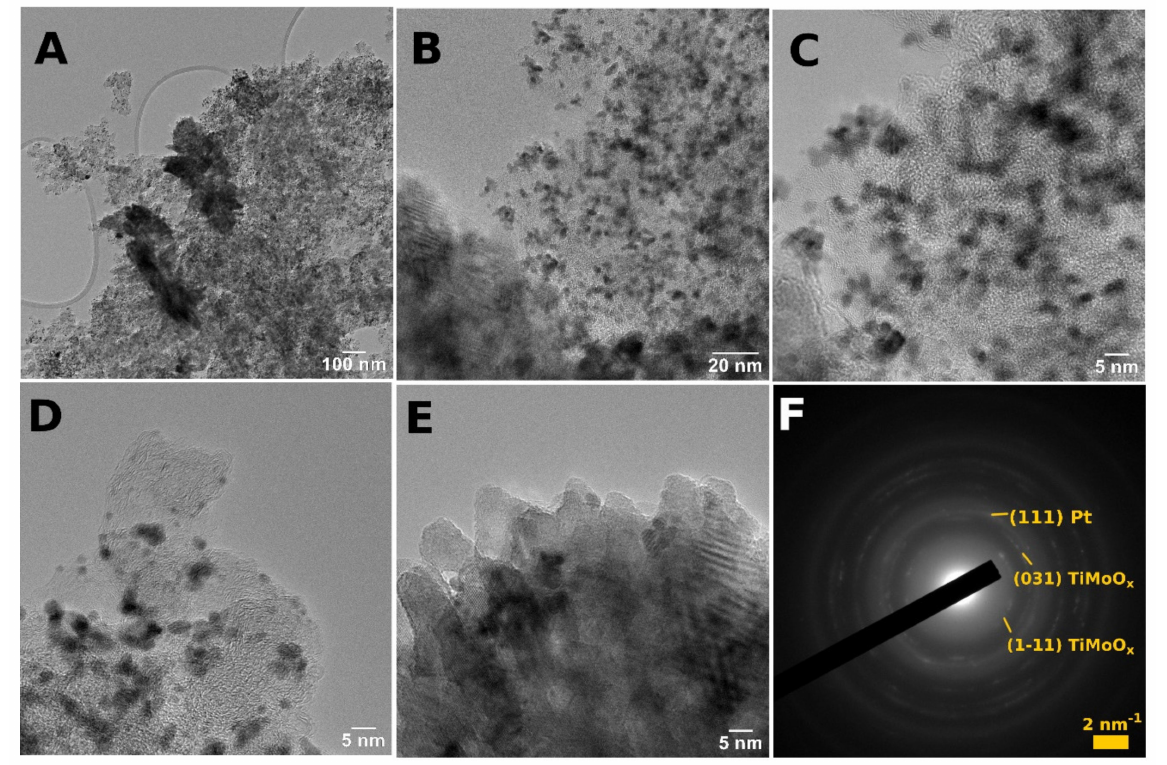
Figure 2. TEM images ( A – E ) and large-area SAED ( F ) of the Pt/75BP electrocatalyst.